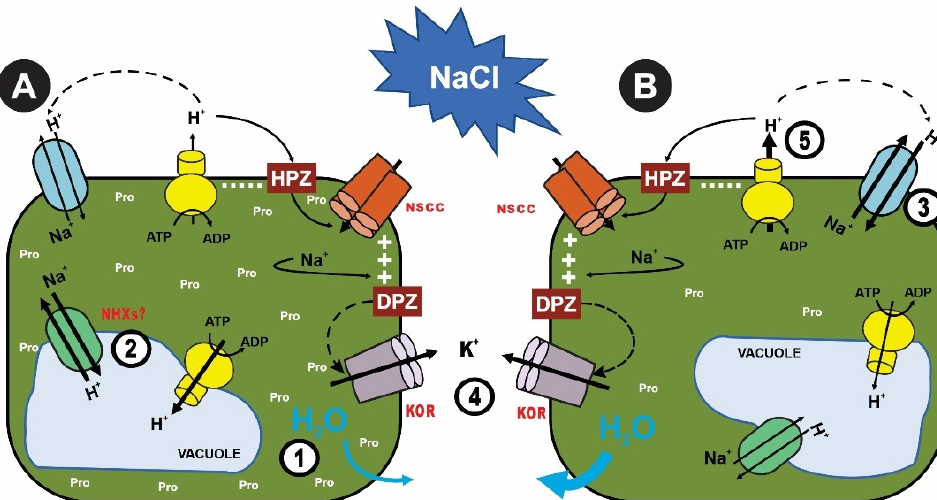
Figure 2. Osmotic adjustment through the accumulation of compatible solutes such as proline in leaves and roots to prevent the loss of water (1). Na+ compartmentalization in vacuole-like struc- tures suggests the involvement of vacuolar and endosomal Na + /H + antiporters (NHX) (2). (3) Na + extrusion or efflux from the cytosol to the apoplast by SOS1 exchangers (3). Regulation of K + home- ostasis through K + retention in roots is crucial in plants (4). (5) Increase in the H + -ATPase activity to cell membrane repolarization or Na + extrusion. KOR: outward-rectifying K+ channels (5). HPZ is hyperpolarization, and DPZ is depolarization. Modified from the work of Quintal, Velarde-Buerdía et al. (2014).